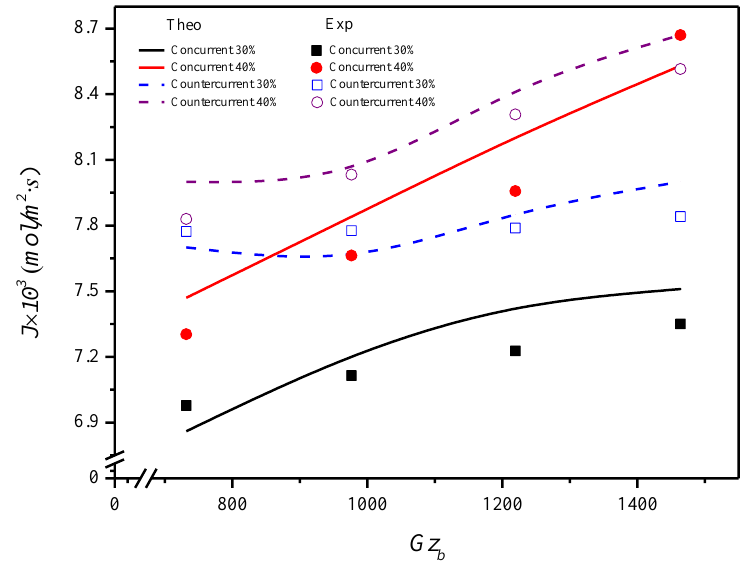
Figure 9. Effects of inlet CO 2 concentration, flow pattern and Gz b on CO 2 absorption flux. Table 2. The accuracy of the experimental results.